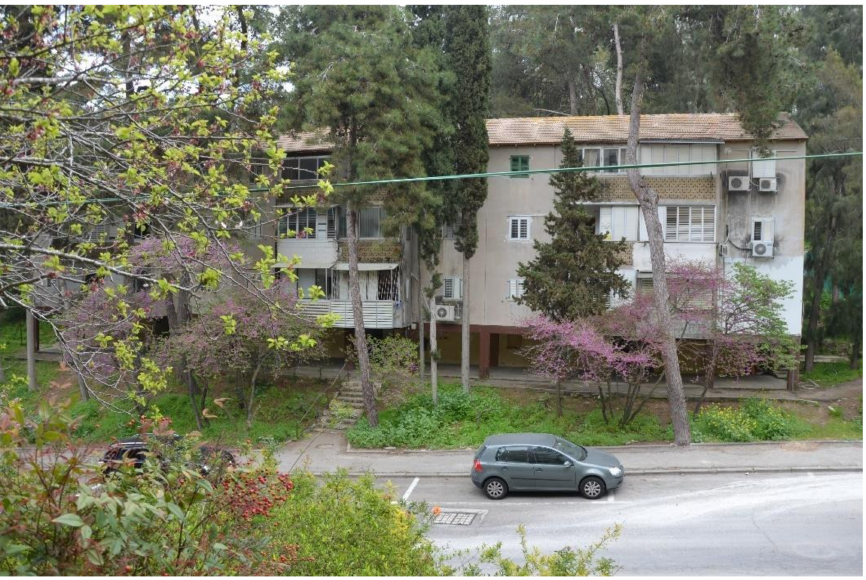
Figure 2. Houses with slated roofs steeped in greenery. Photographed by the authors,